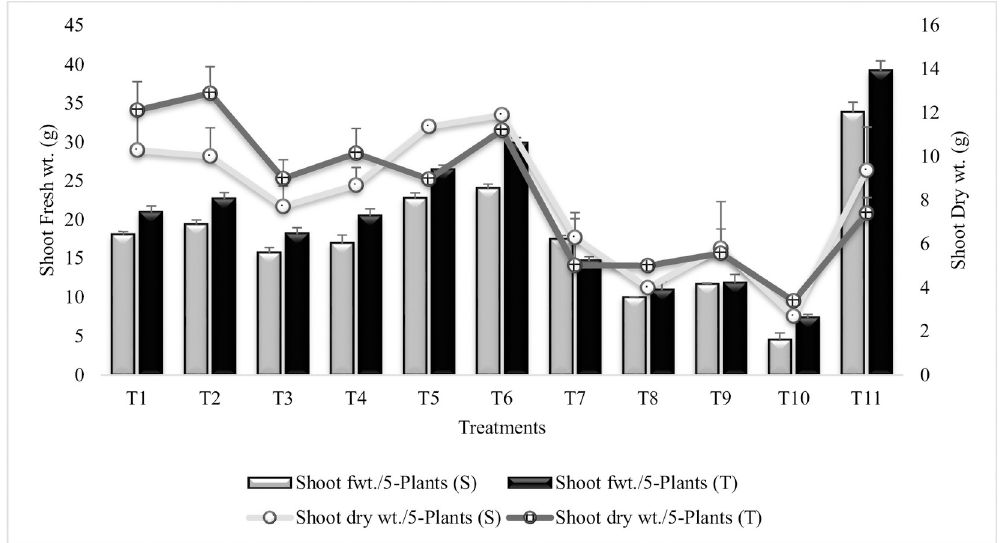
Fig 9. Shoot fresh and dry weights of chickpea grown in sandy soil. Data are means of four replicates along with standard error bars (S-Sensitive Variety; T-Tolerant Variety).